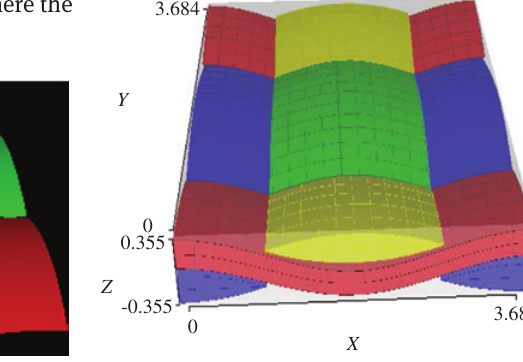
Figure 7: Final model of the